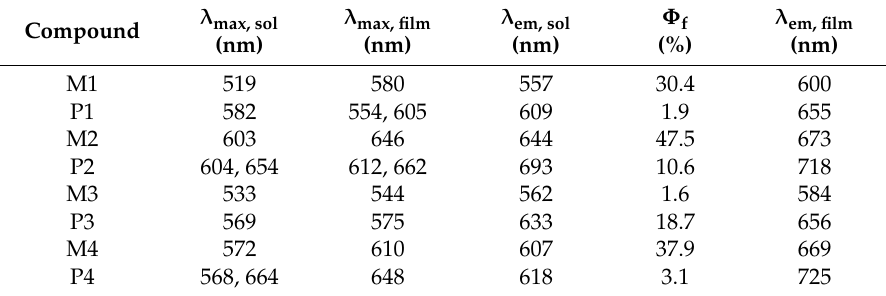
Figure 4. Normalized fluorescence emission spectra of monomers (M1, M2, M3 and M4) and copolymers (P1, P2, P3 and P4) in: THF ( a ); and films ( b ). Table 1. Optical data of the monomers and copolymers.